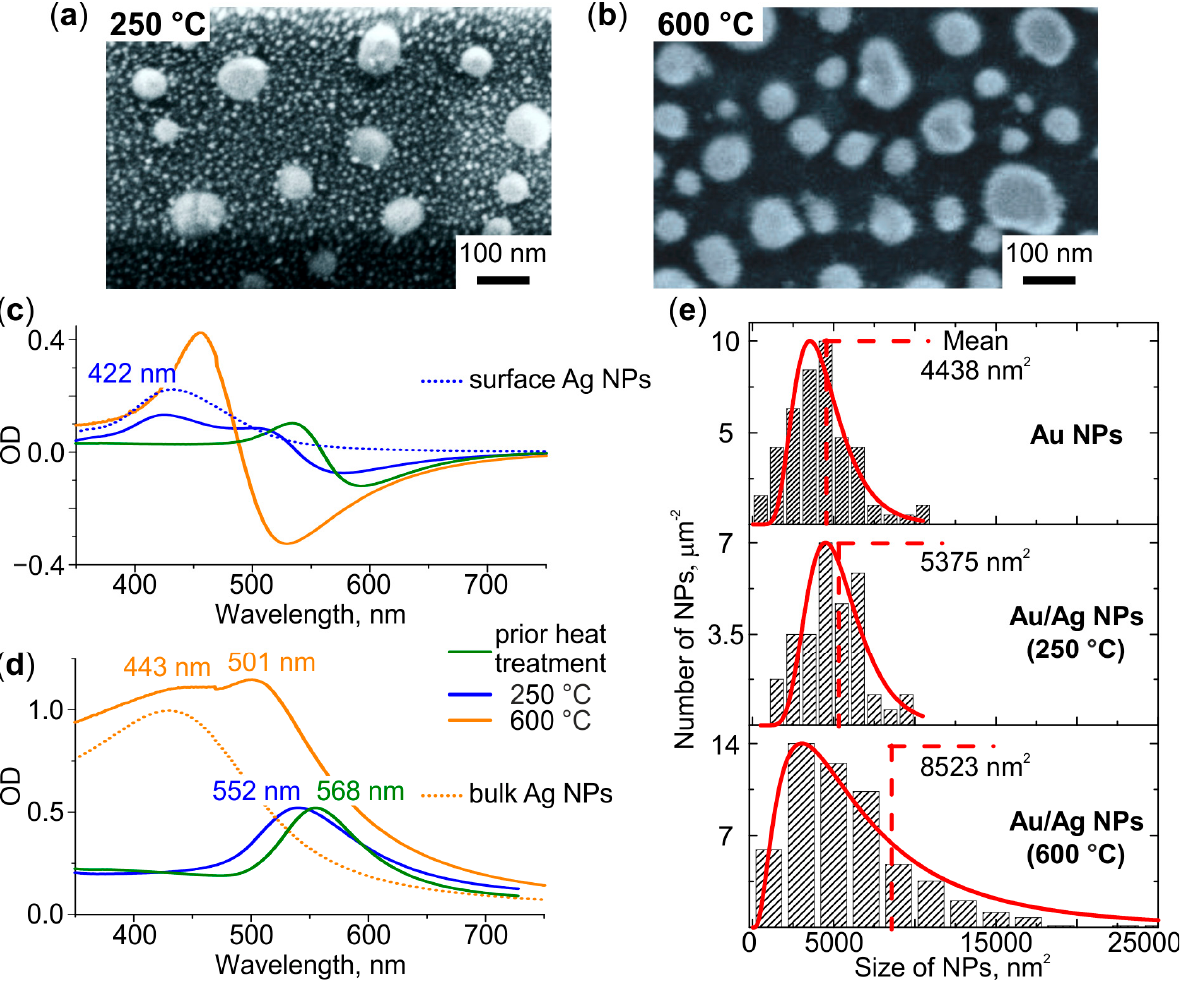
Figure 4. SEM images of the glasses containing Au NPs and Ag + ions after heat treatment in air at ( a ) 250 °C and ( b ) 600 °C. ( c ) Differential and ( d ) bulk spectra of the treated glasses. The dotted spectra correspond to glasses containing Ag NPs on the surface (blue) or in the bulk (orange). ( e ) NPs size distributions in glasses containing Au and Au/Ag NPs (formed at a different temperature, denoted), and corresponding log-normal approximations (red). Mean sizes of NPs are denoted.